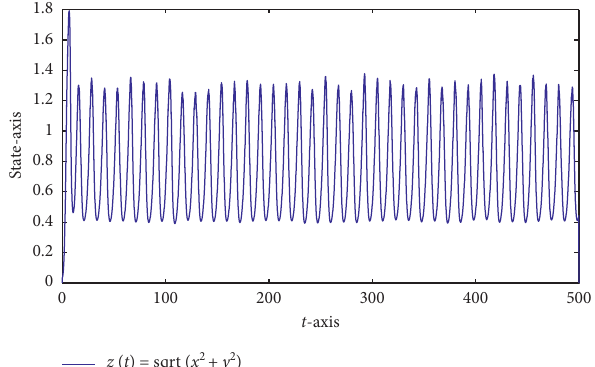
Figure 8: Stochastic persistence of (5) with n � 2 and x ( 0 ) � y ( 0 ) � 0 .